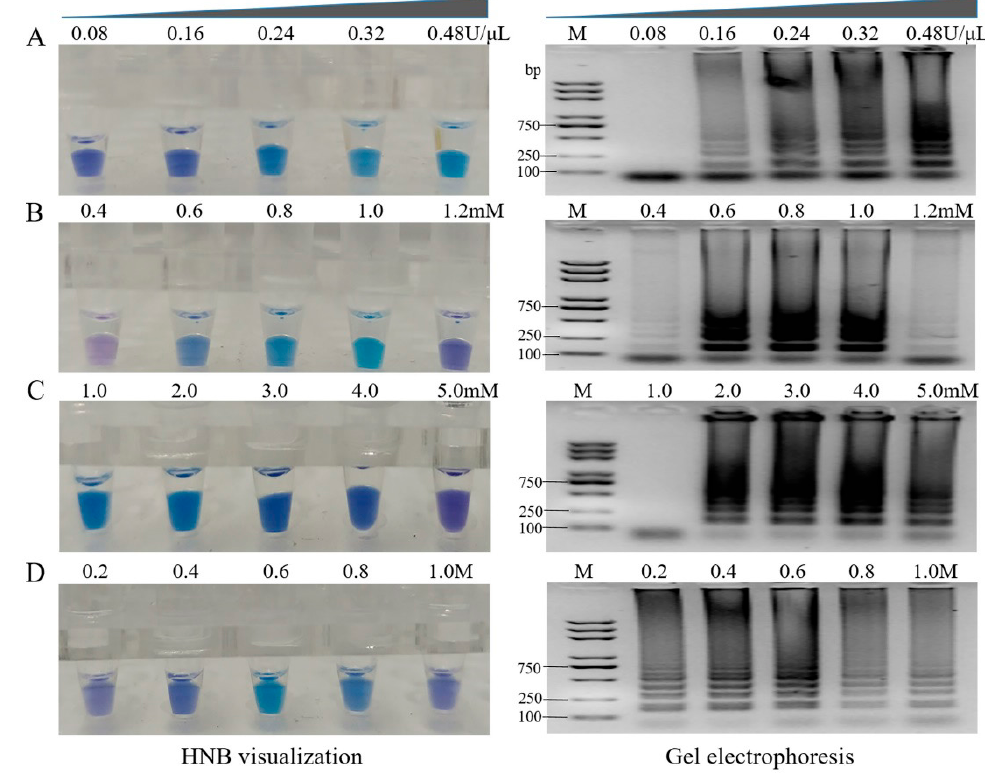
Figure 5. Optimization of the concentration of Bst DNA polymerase ( A ), dNTP ( B ), Mg 2+ ( C ), and betaine ( D ), respectively. M. Trans 2K Plus DNA marker.